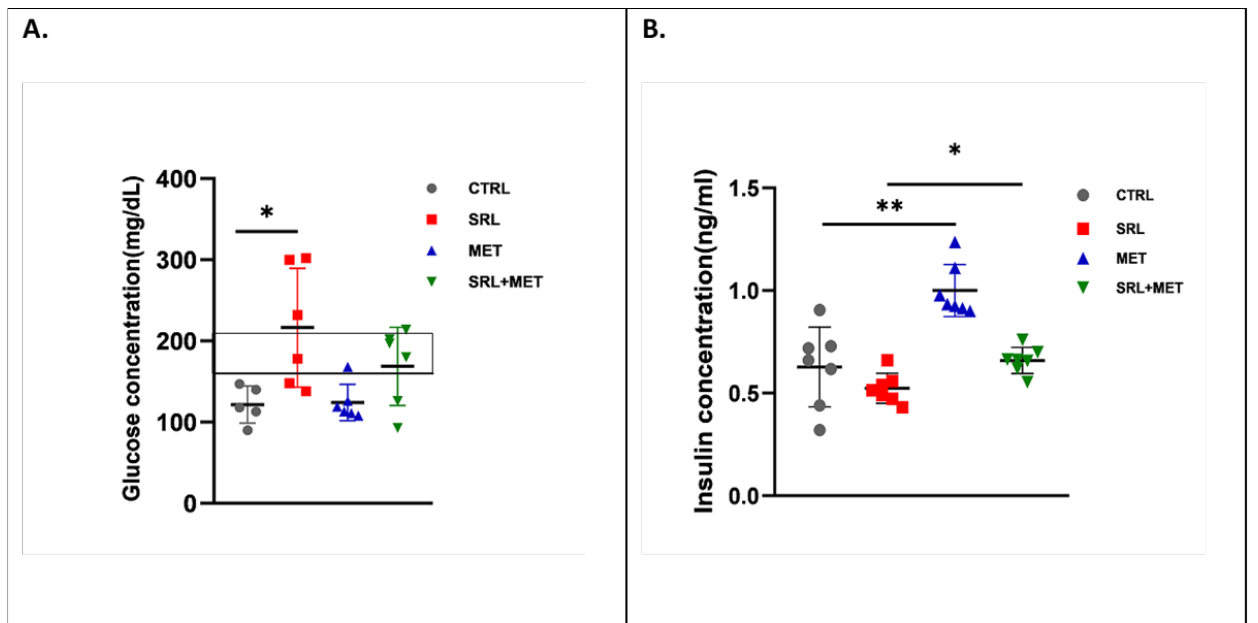
Figure 3. Serum glucose and insulin levels of Balb/C. ( A ) Serum glucose levels in mice after 4 weeks of treatment with Water (CTRL)or SRL MET orSRL+MET therapy. Random blood glucose levels in the prediabetic range are represented by the box. ( B ) Serum Insulin levels in mice after 4 weeks of treatment with CTRL, MET or SRL alone, or MET +SRL ( n = 4–6 per group), Data are means ± SD. * p < 0.05, ** p < 0.01.